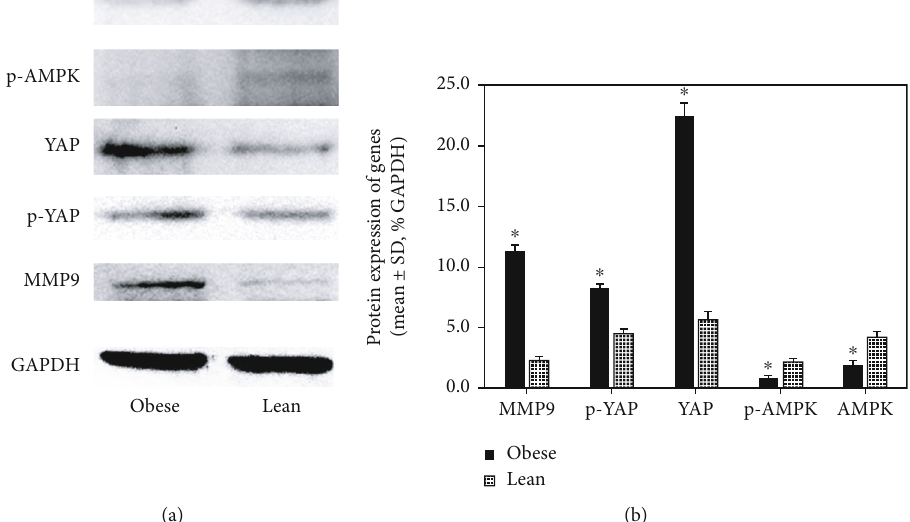
Figure 4: MMP9, AMPK, and YAP protein expression in these subcutaneous tumors was evaluated semiqualitatively. ∗ P < 0 : 05 versus lean.